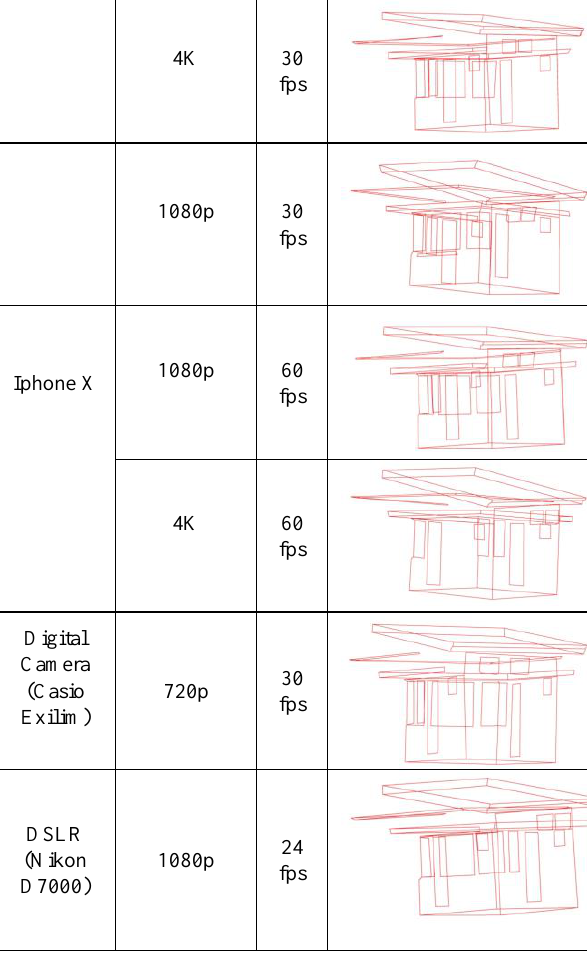
Table 5. 3D wireframe